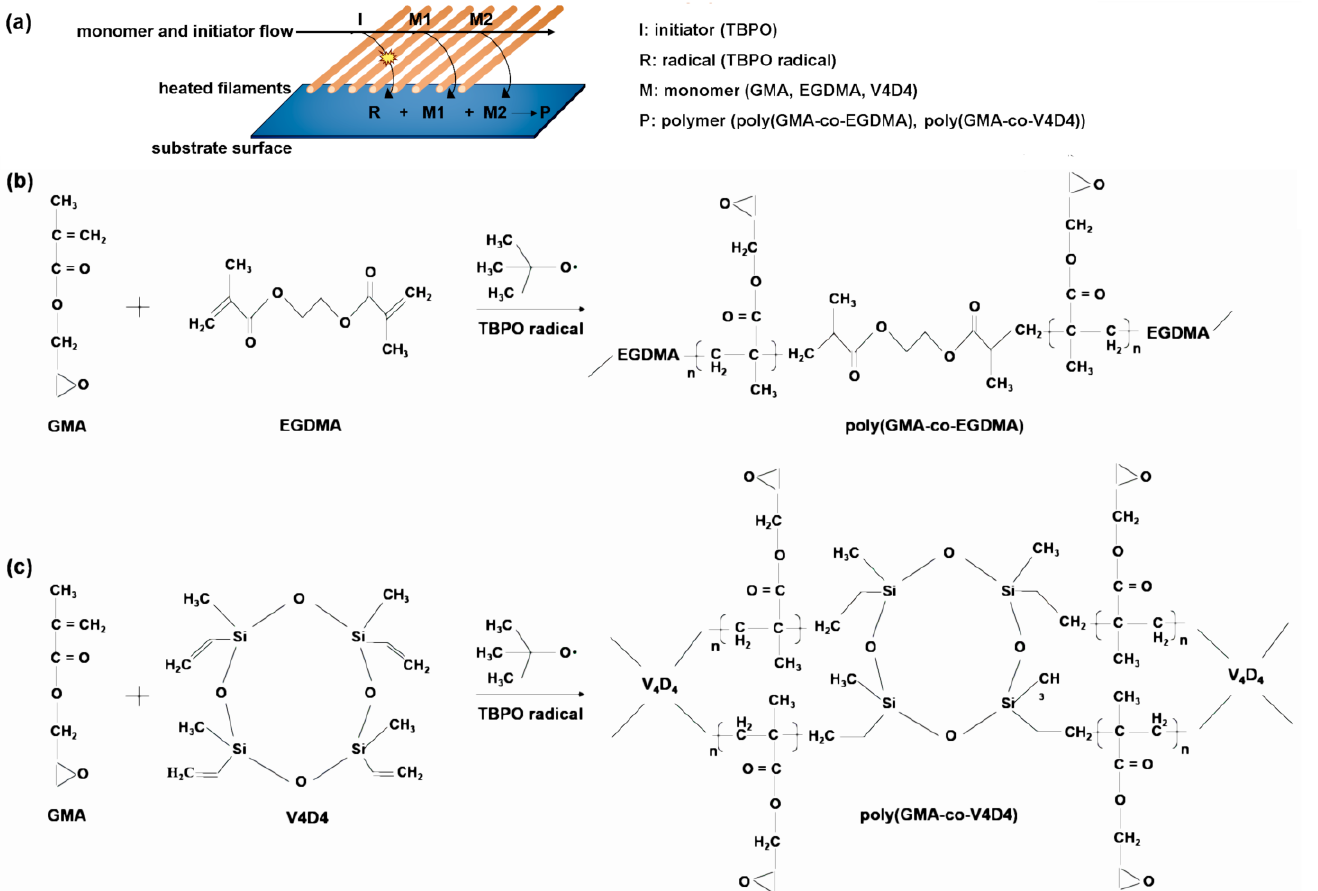
Figure 4. FTIR spectra of ( a ) GMA, EGDMA and V4D4 homopolymers and their copolymers, ( b ) poly(GMA-co-V4D4) copolymers, and ( c ) poly(GMA-co-EGDMA) copolymers.